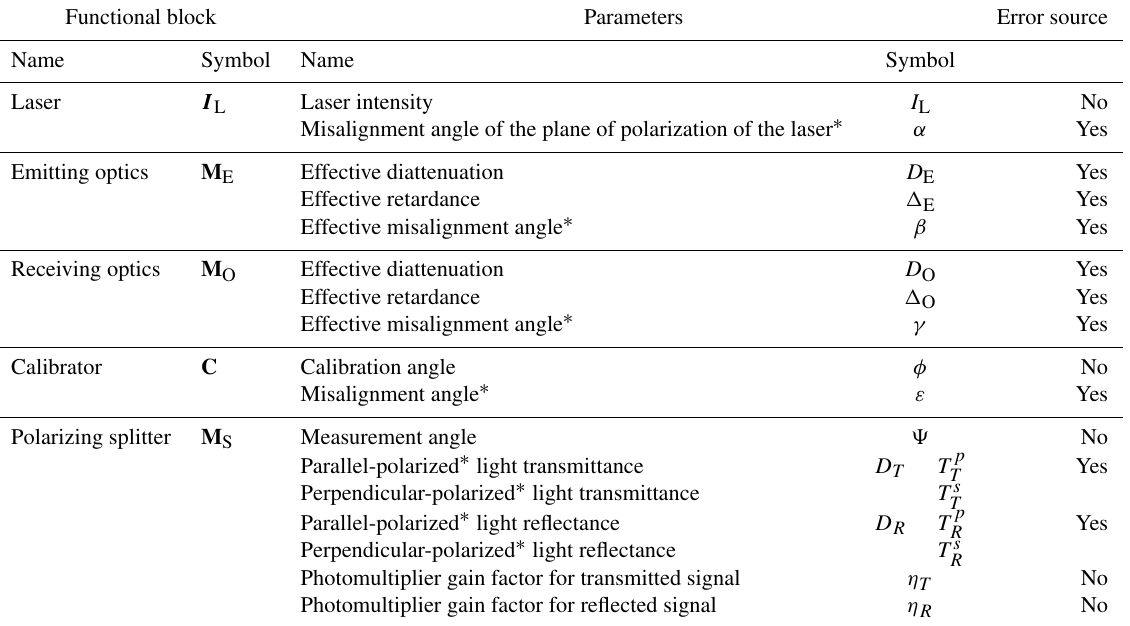
Table 1. List of the functional blocks and lidar parameters used for describing the lidars. The error source column checks the parameters used for the assessment of the depolarization